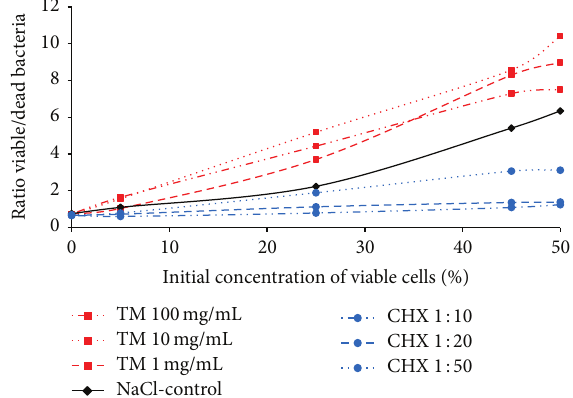
Figure 5: Effect of CPP/ACP (red), chlorhexidine (CHX) (blue), and saline solution (control) (black) on the viability of S. mutans in vitro . A suspension of S. mutans was incubated with CPP/ACP and chlorhexidine solutions in different concentrations. After incu- bation, the samples were admixed to proportions of the basic suspension. The amount of vital and dead bacteria was determined by BacLight bacterial viability assay. The measurements were carried out in duplicate and the ratio was calculated: emission 530 nm and emission 620 nm are representing emission vital and emission dead bacteria,